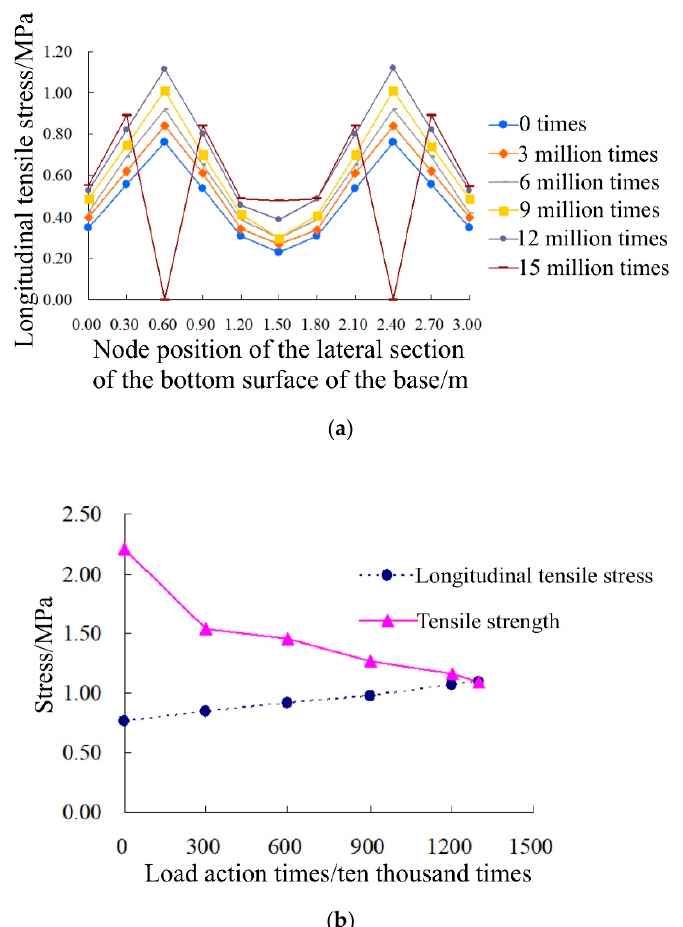
Figure 23. Longitudinal mechanical characteristics of base plate under fatigue load (working condi- tion 3). ( a ) Cross-sectional stress development diagram at the maximum longitudinal tensile stress of the base plate; ( b ) number of cracks at the maximum longitudinal tensile stress of the base plate. (4) Comparative analysis